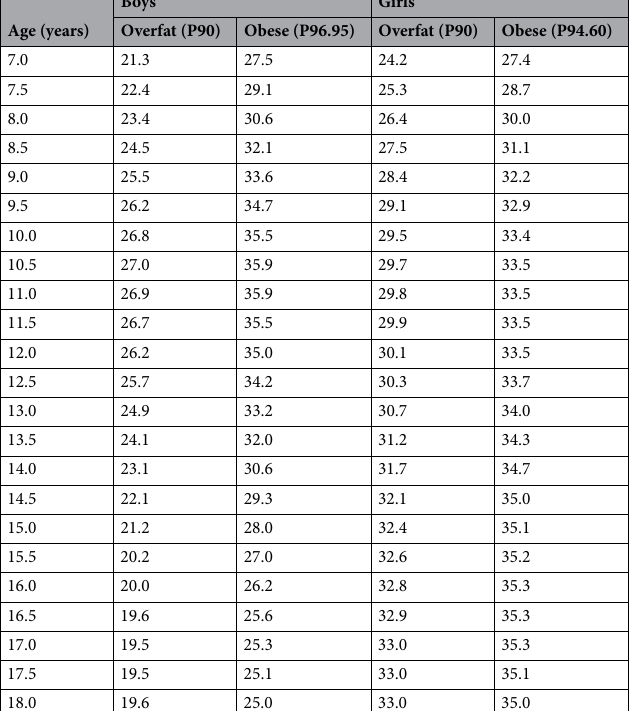
Table 2. The new body fat percentage cut-off values (%) for overfat and obesity in children and adolescents aged 7–18 years (P90: 90th centile, P96.95: 96.95th centile, P96.40: 96.40th centile values).